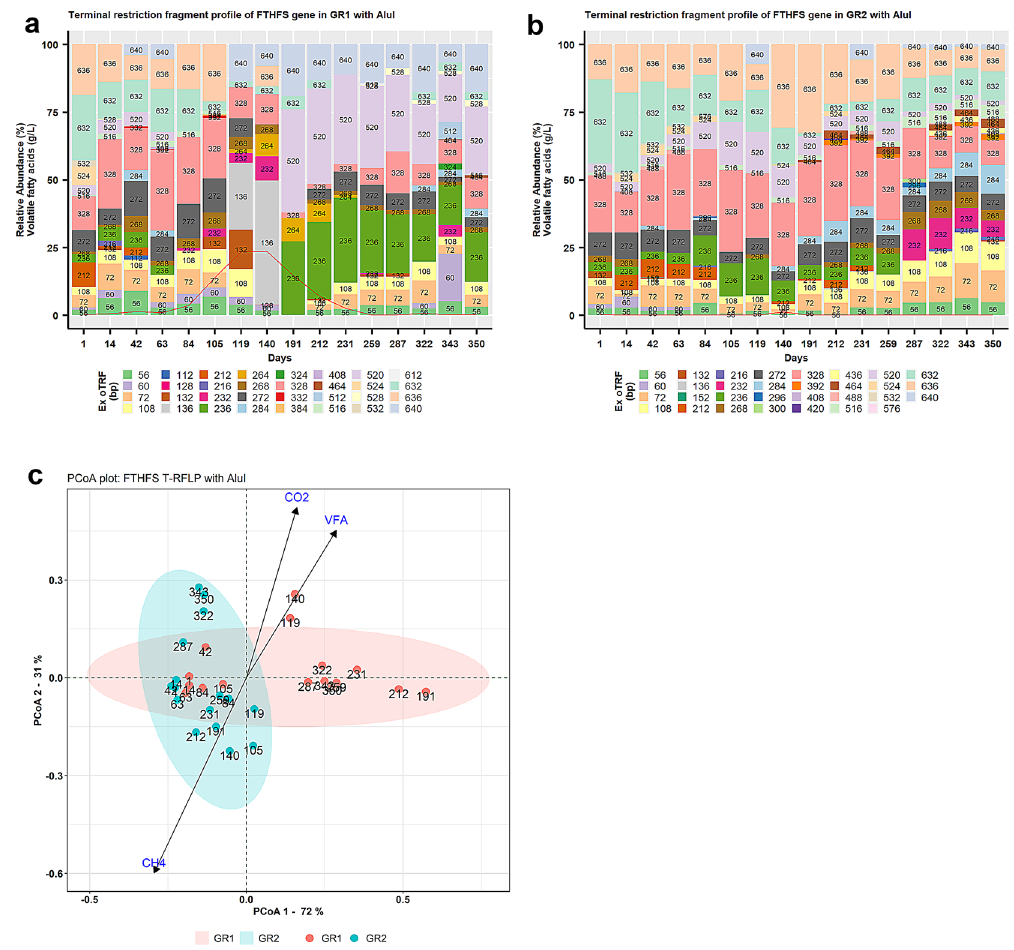
Figure 1. Experimental terminal restriction fragment length polymorphism (T-RFLP) profile of FTHFS gene representing Ex oTRF with restriction enzyme AluI for ( a ) experimental reactor GR1 and ( b ) control reactor GR2. The red line represents the level of total volatile fatty acids (g/L) at the respective time-point. ( c ) Principal coordinate analysis (PCoA) plot showing microbial beta diversity reactors GR1 and GR2 using FTHFS T-RFLP profile with AluI. VFA, CH 4 and CO 2 are the environmental vectors which represent the level of total volatile fatty acids (g/L), methane content (%) and carbon dioxide content (%),